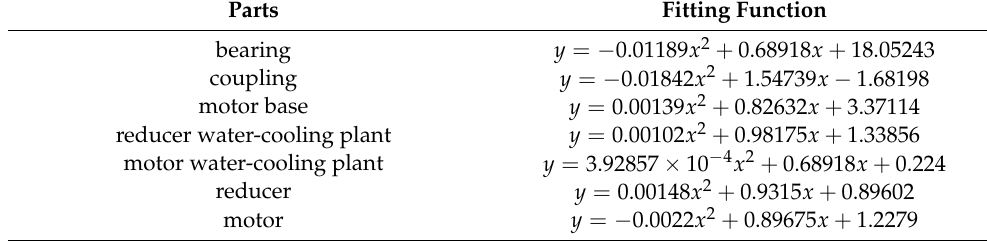
Table 8. Fitting function of temperature measurement points of components under different cooling water temperatures.